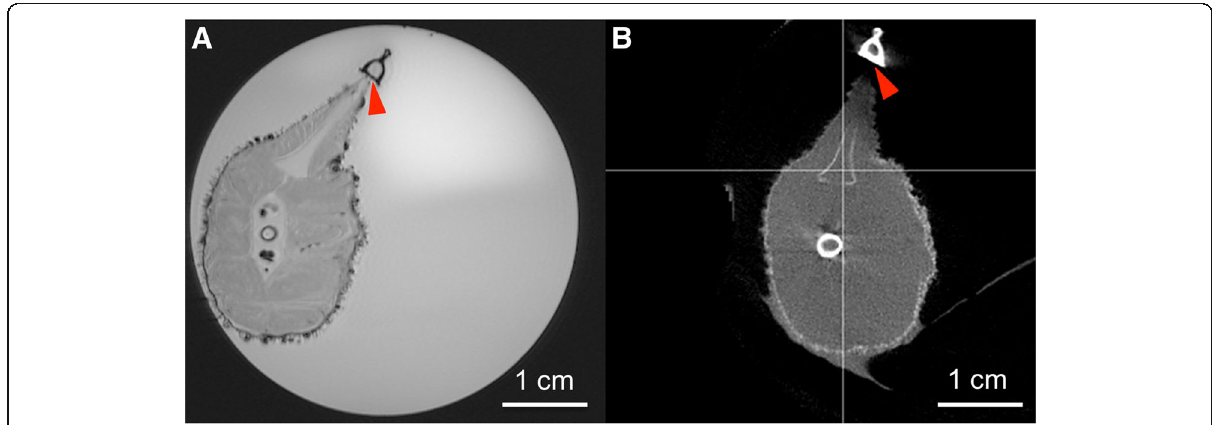
Fig. 5 Spine structure. Spine structure analyses by MRI image showing any evidence of soft tissue at the posterior side of the spine (red arrowhead) ( a ). Internal spine structure analyses by micro CT scan showing any evidence of a duct/canal at the posterior side of the spine hard tissue (calcified structure), red arrowhead showing the calcified tissue at the posterior side of the spine without any duct/canal ( b ). In both analyses, the only hollow on the spine, at the center, is filled with cartilaginous